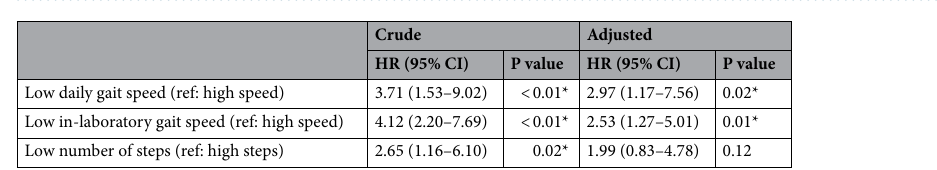
Figure 1. Kaplan–Meier estimates of cumulative incidence of disability according to the three gait parameters ( A : daily gait speed, B : in-laboratory gait speed, C : number of steps).